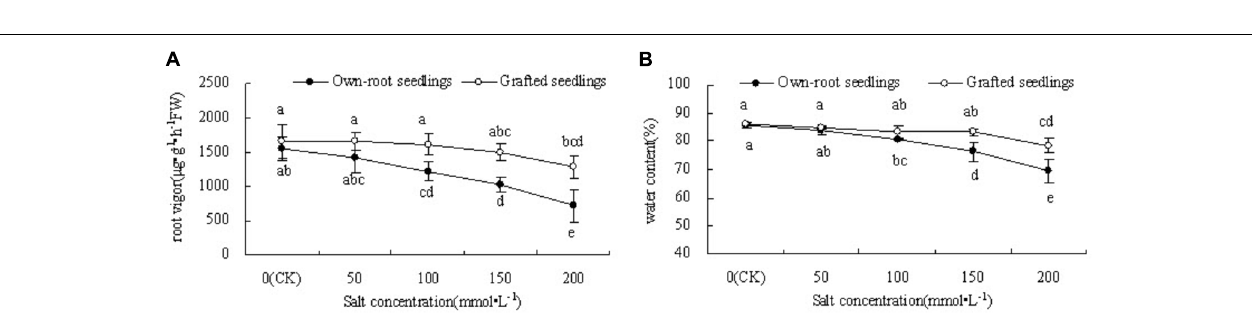
FIGURE 1 | Root and leaf Na + content (A,B) and K + content (C,D) of mulberry own-root seedlings and grafted seedlings under salt stress.